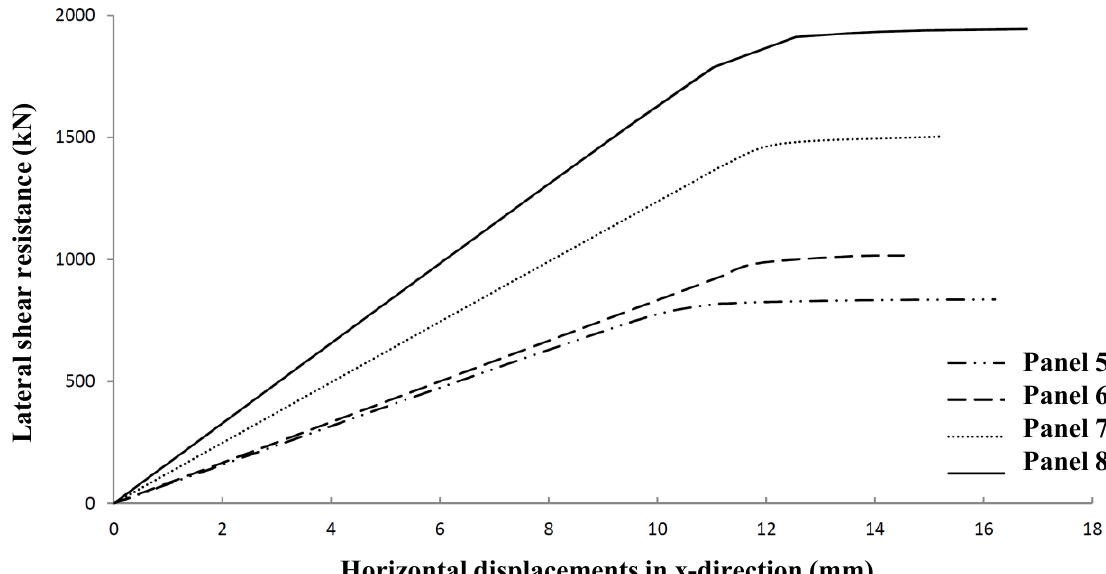
Figure 24. Lateral shear resistance versus out of plane deformations for Panels 5 to